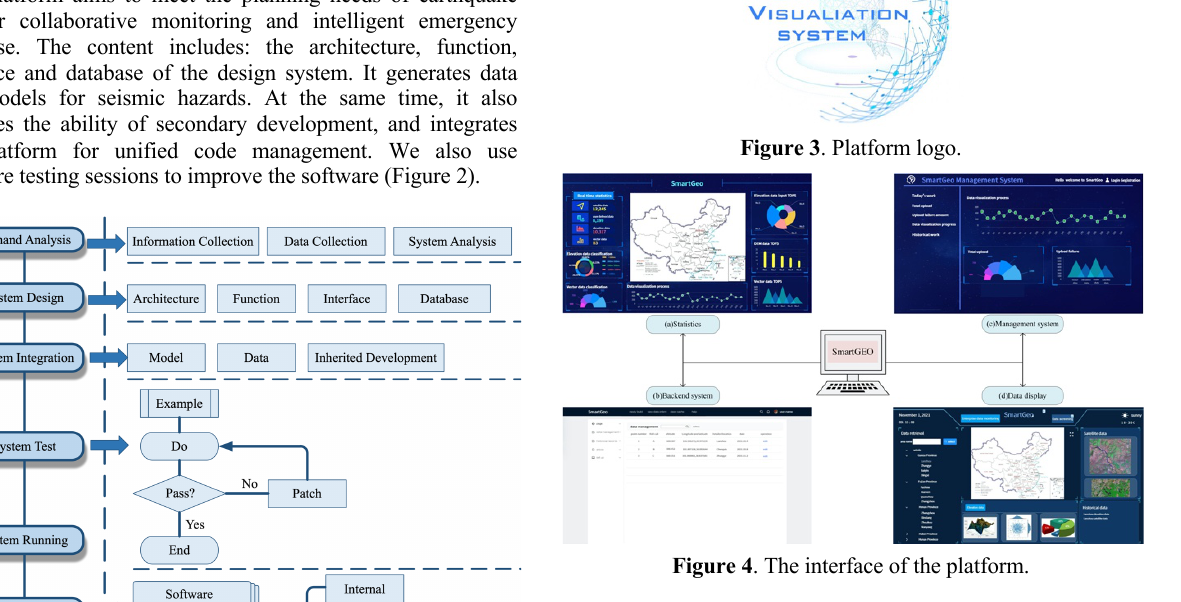
Figure 4 . The interface of the